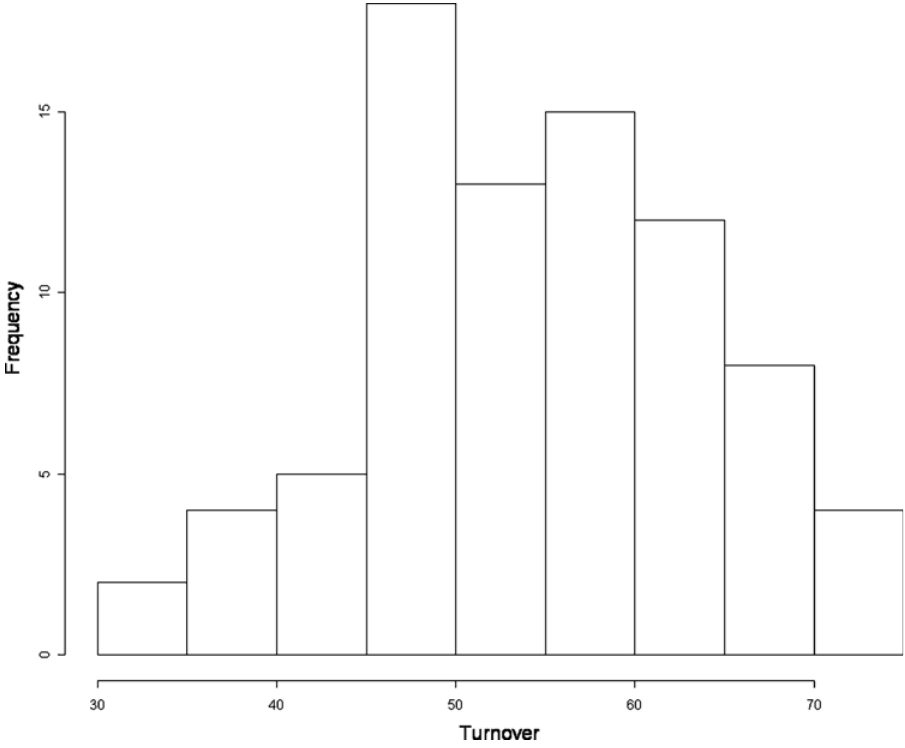
Figure 1. Frequency distribution of the temporal species turnover in the 81 sites sampled in 1966 and 1996.